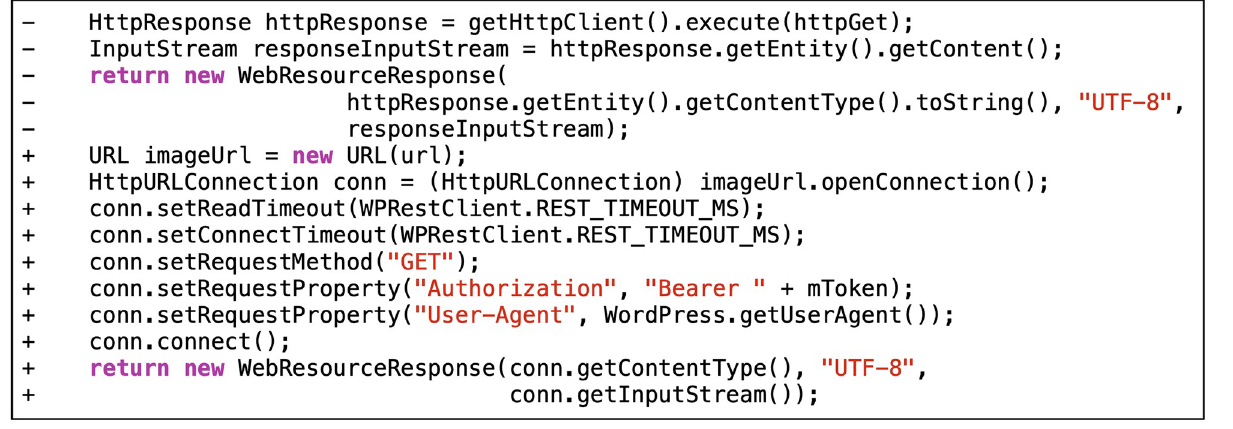
Fig 3. An example of code changes in a commit.